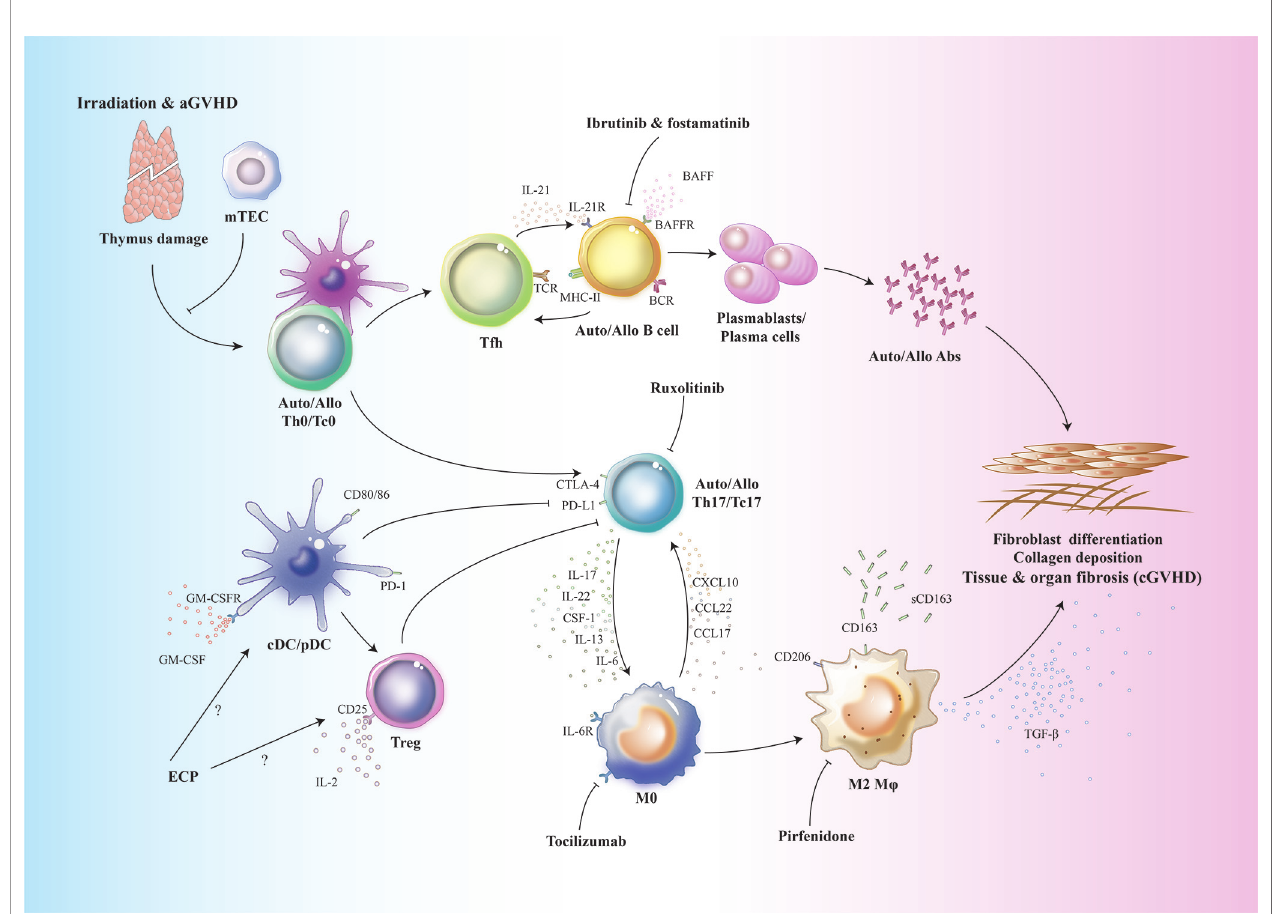
FIGURE 1 | Schematic overview of the functional contributions of APCs to cGVHD. Conditioning regimens such as irradiation, chemotherapy as well as aGVHD cause host thymus damage. Thymic dysfunction contributes to the defective T cell negative selection and release of auto-/alloreactive T cells into periphery. These Th0/Tc0 cells are activated by host or donor DCs and differentiate into auto-/alloreactive Th17/Tc17 and T-follicular helper (Tfh) cells. In germinal center, Tfh cells produce IL-21 which results in activation and expansion of allo-/autoreactive B cells. Elevated levels of BAFF could also contribute to the aberrant B cell expansion. These auto-/alloreactive B cells differentiate into plasmablasts or plasma cells which produce auto-/alloantibodies. Host tissue resident macrophages are eliminated and replaced by donor monocyte derived tissue resident macrophages. These macrophages recruit auto-/alloreactive Th17/Tc17 cells via production of chemokines. After migration into target organs, auto-/alloreactive Th17/Tc17 cells further secrete IL-17 to induce more macrophage in fi ltration. Under the in fl uence of multiple cytokines such as CSF-1, IL-13 and IL-6, donor monocyte derived macrophages are polarized into TGF- b -producing M2 macrophages. The pro fi brotic cytokine TGF- b , together with auto-/alloantibodies, contribute to the pathogenesis of cGVHD via inducing fi broblast differentiation into myo fi broblasts which promote collagen synthesis and deposition in target organs and tissues. ECP, extracorporeal photopheresis; Fostamatinib, a Syk inhibitor; Ibrutinib, Bruton ’ s tyrosine kinase inhibitor; Pirfenidone, an anti- fi brotic drug; Ruxolitinib, a selective JAK1/2 inhibitor; Tocilizumab, anti-IL-6R monoclonal